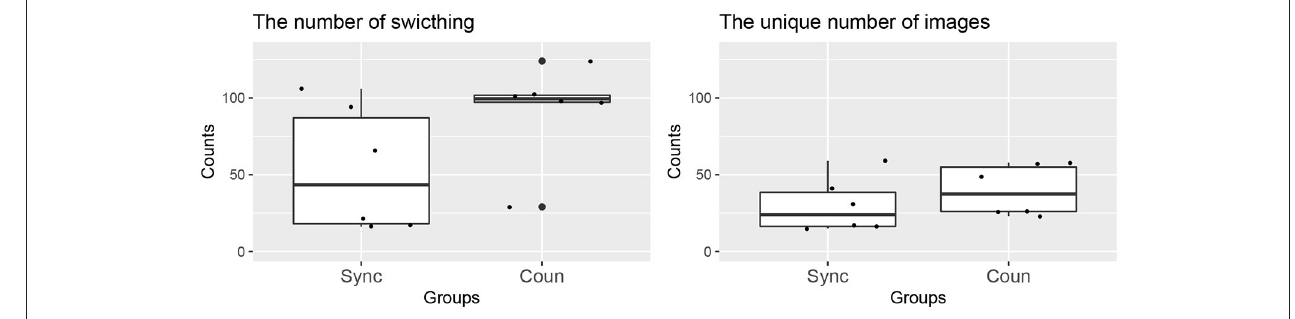
FIGURE 3 | Counting results for model behavior.